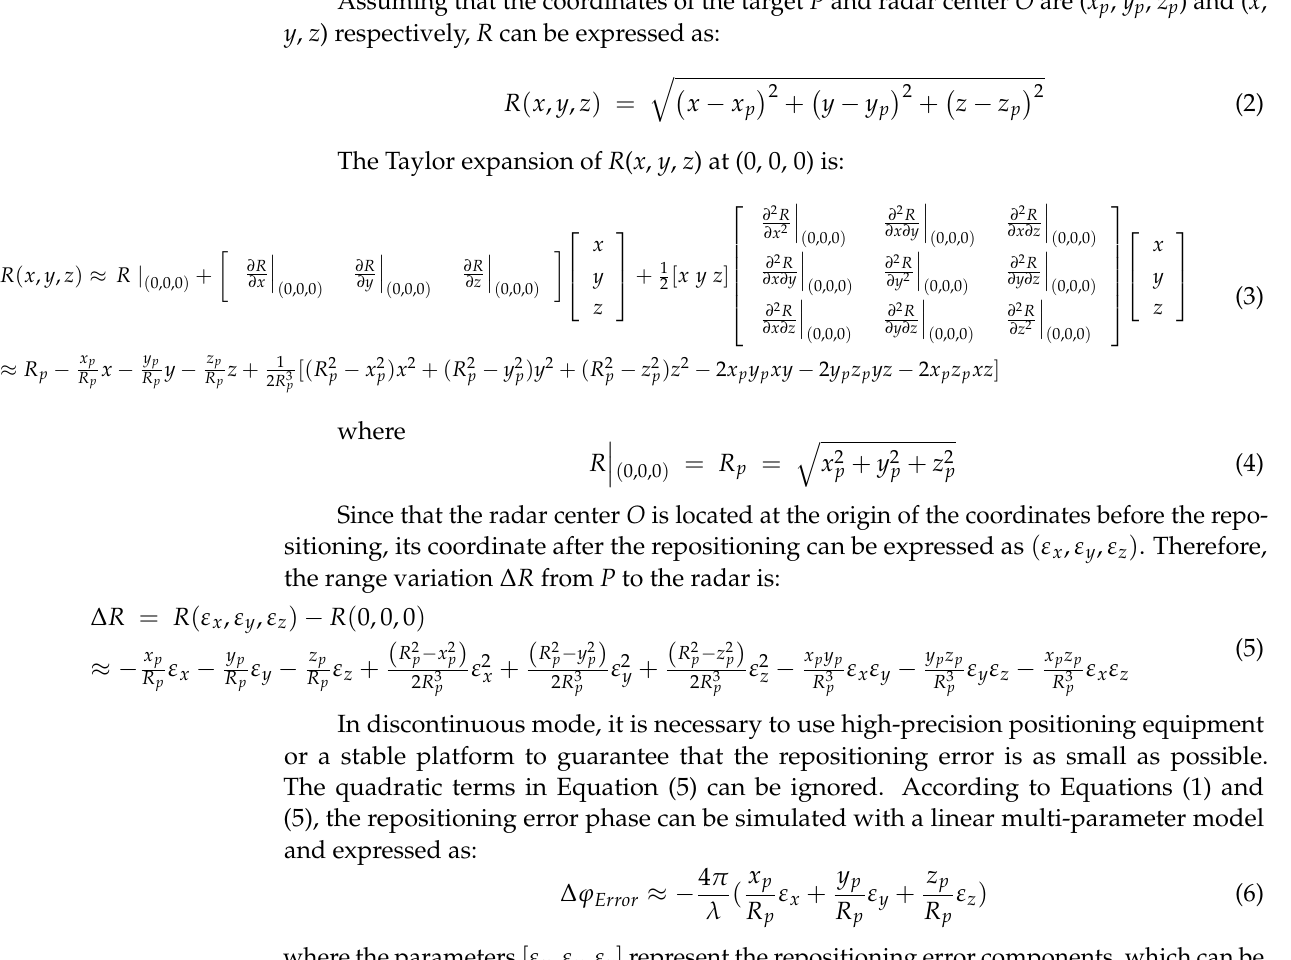
Figure 2. Ground-based synthetic aperture radar (GB-SAR) geometry.